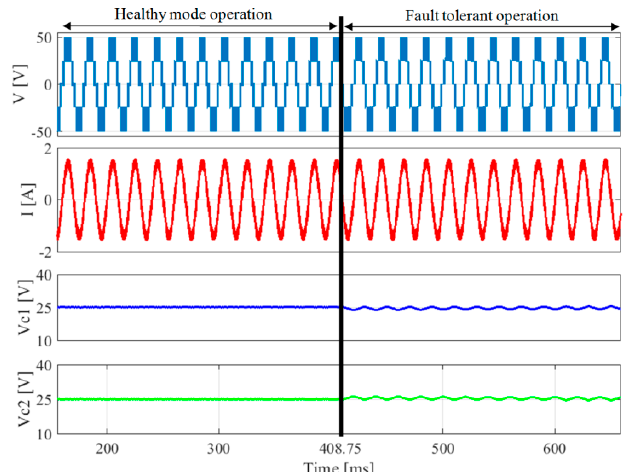
Figure 4. Simulation results for fault-tolerant operation of the inverter in case of fault occurrence in D C4 .